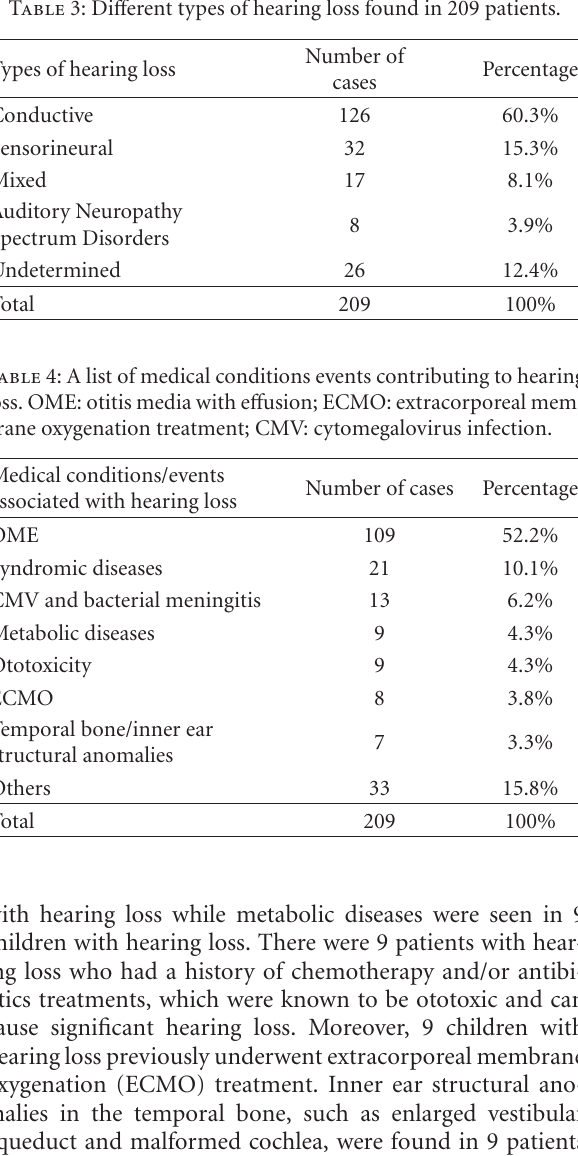
Table 3: Di ff erent types of hearing loss found in 209 patients.